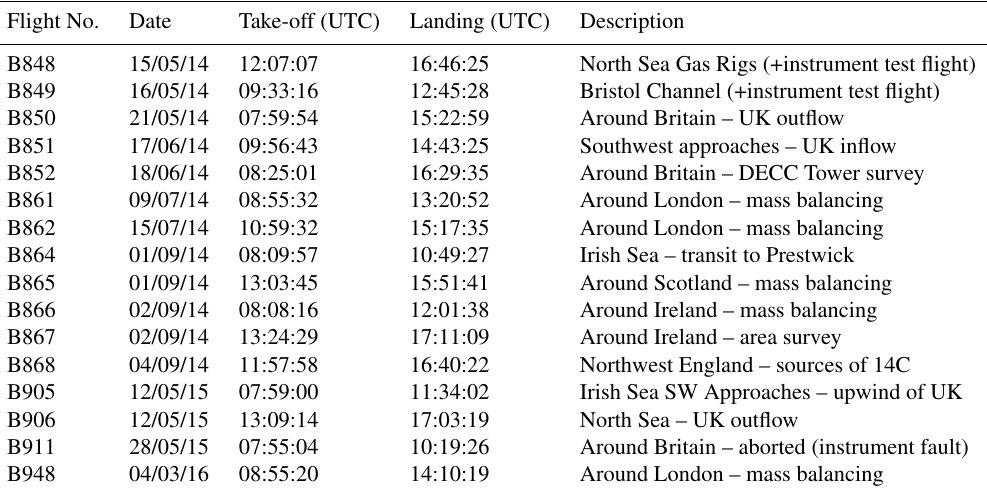
Table 6. Diary of FAAM survey flights for GAUGE between May 2015 and March 2016, including take-off and landing times, sampling locations, and a brief description of mission profiles. Flight